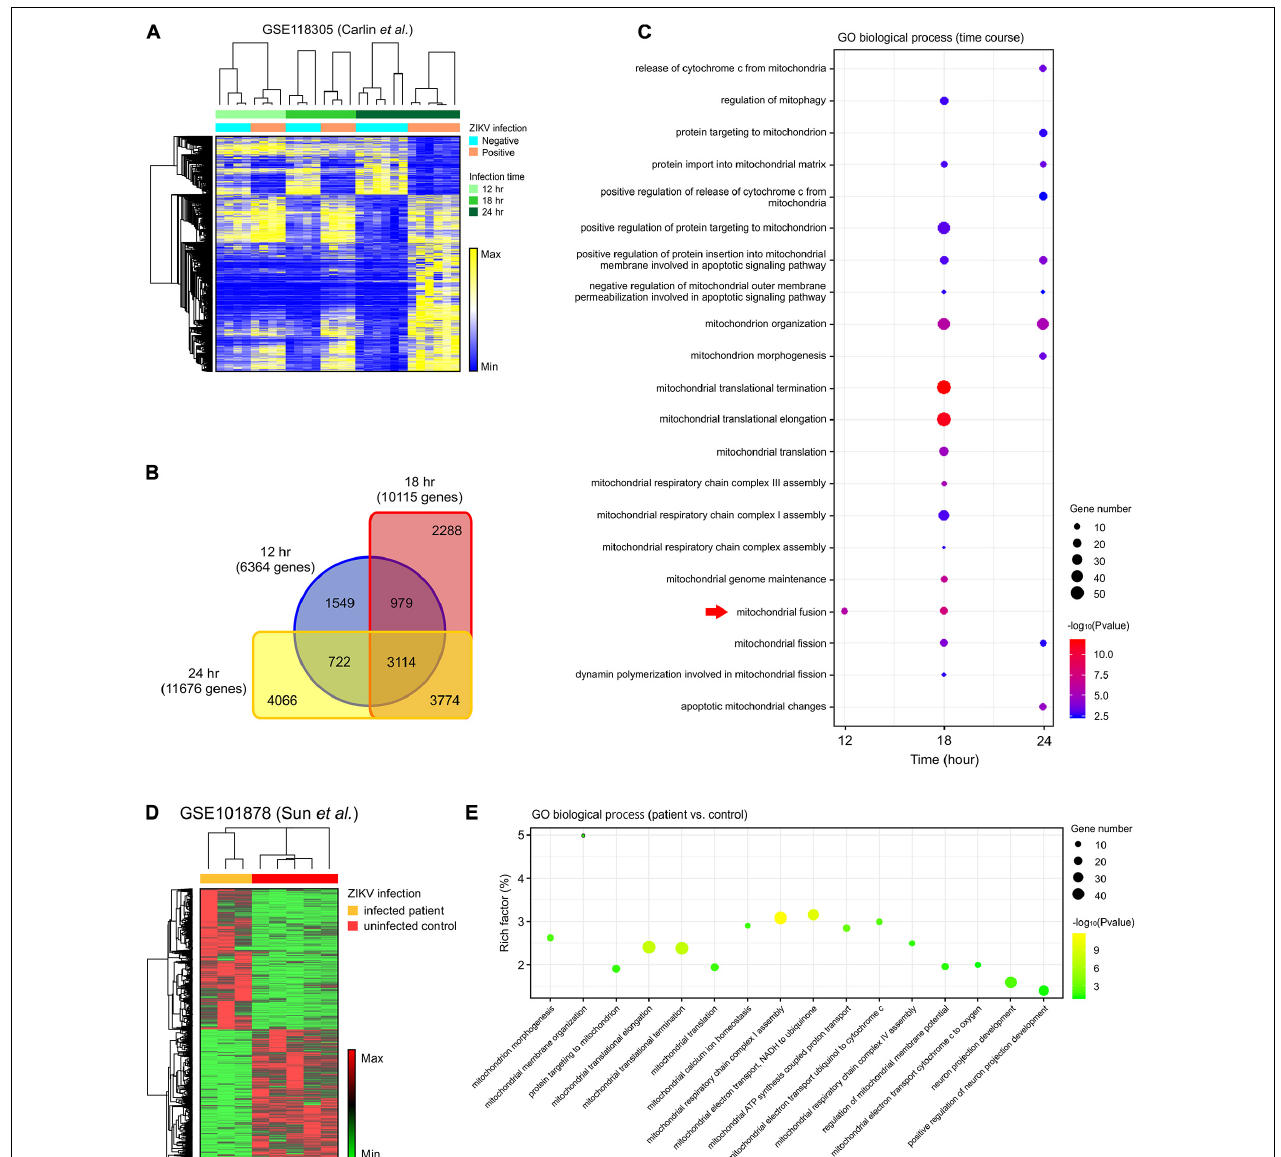
FIGURE 1 | DEGs in the mitochondria-related pathways were enriched in ZIKV-infected cells. (A) A heatmap of all DEGs between ZIKV positive and negative cells in an RNA-seq dataset (GSE118305). (B) Venn diagram displaying the overlap of DEGs at each time-point in (A) . (C) Dot plot of representative mitochondria-related GO biological process enriched by DEGs at 12, 18, and 24 h post-infection in the GSE118305 data set. The x -axis represents the time post-ZIKV infection, and the y -axis represents the various pathways. Dot size represents the number of different genes, and the color indicates the p -value. Red arrow highlights the mitochondrial fusion-related pathway. (D) A heatmap of DEGs between ZIKV infected patients and uninfected control samples in an RNA-seq dataset (GSE101878). (E) Dot plot of representative mitochondria-related GO biological process enriched by DEGs in (D) . The x -axis represents the name of the pathway, and the y -axis represents the Rich factor. Dot size represents the number of different genes, and the color indicates the p